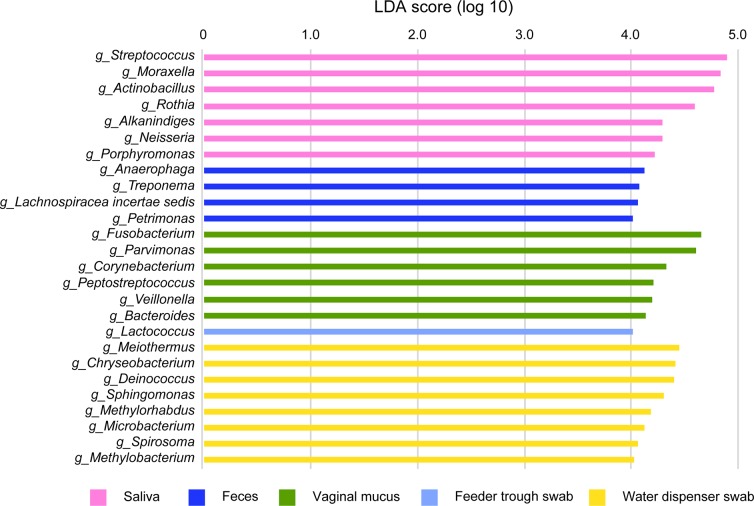
Results of the LEfSe analysis show significantly discriminative genera among the five sample groups.Genera with an LDA score >4.0 (p<0.01) are depicted, based on their scores. Prefixes of the bacterial names indicate the following ranks: “o” for order, “f” for family, and “g” for genus.